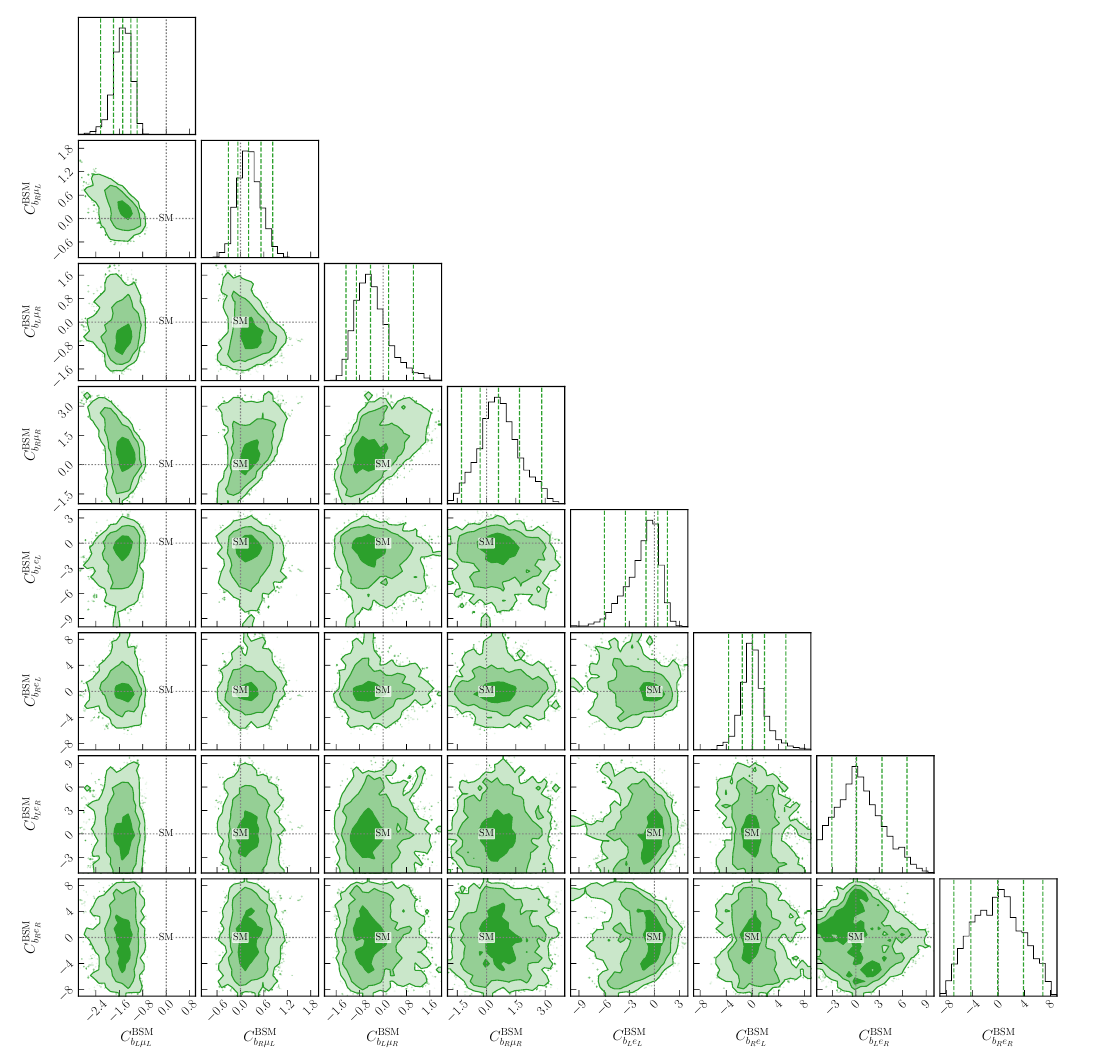
Figure 5 . Global (cid:12)t to the 8 Wilson coe(cid:14)cients in muons and electrons, combining ‘clean’ and ‘hadronic sensitive’ data.